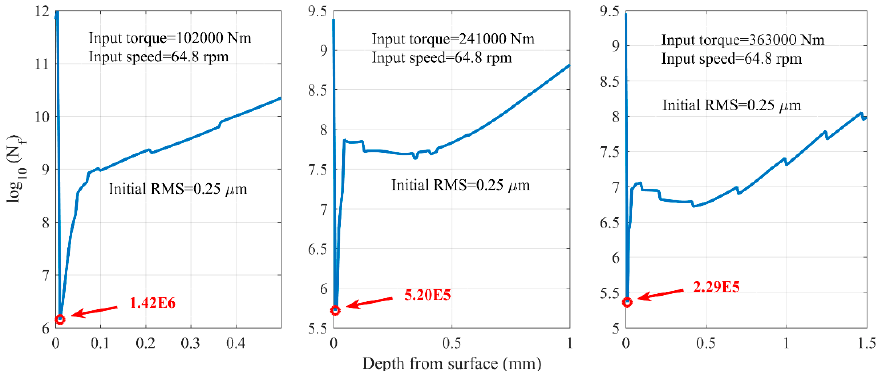
Figure 11. The contact fatigue lives under different input loadings of the first loading cycle with initial surface roughness.